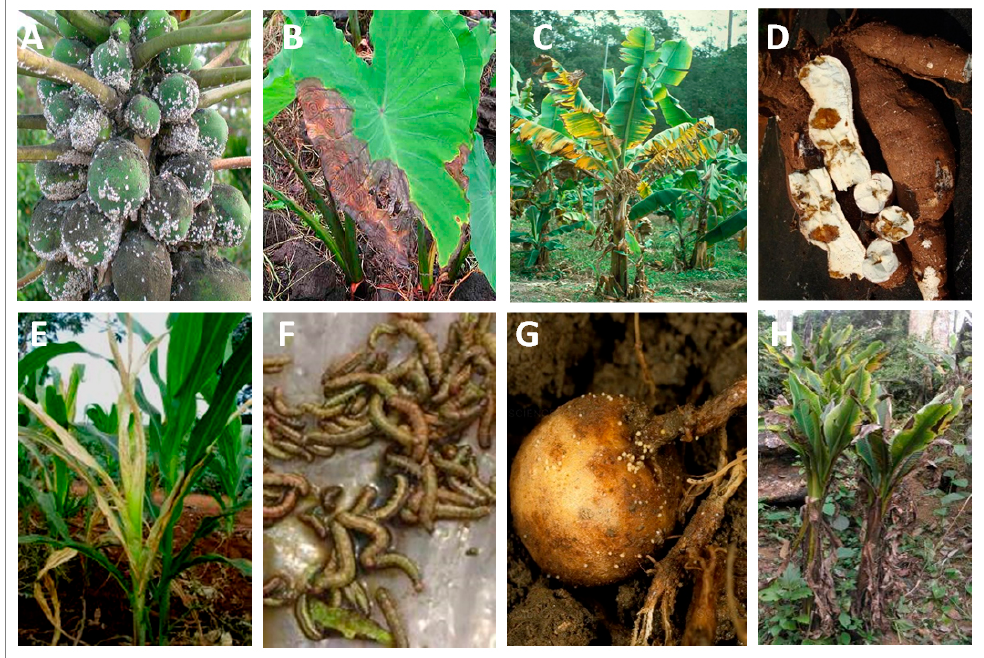
Figure 1. Examples of a few transboundary pests that have caused significant economic damage to food production and posed a major risk to germplasm transfers in sub-Saharan Arica. ( A ) Papaya mealybug ( Paracoccus marginatus ), ( B ) Taro blight ( Phytophthora colocasiae ), ( C ) Panama disease ( Fusarium oxysporum Tropical Race 4), ( D ) Cassava brown streak (cassava brown streak ipo- moviruses), ( E ) Maize lethal necrosis (Maize chlorotic mottle virus), ( F ) Fall armyworm ( Spodoptera frugiperda ), ( G ) Potato cyst nematode ( Globodera pallida ), and ( H ) Banana bunchy top (Banana bunchy top virus) Table 1. Some of the most economically important disease outbreaks, caused by pests introduced into sub-Saharan Africa (SSA).